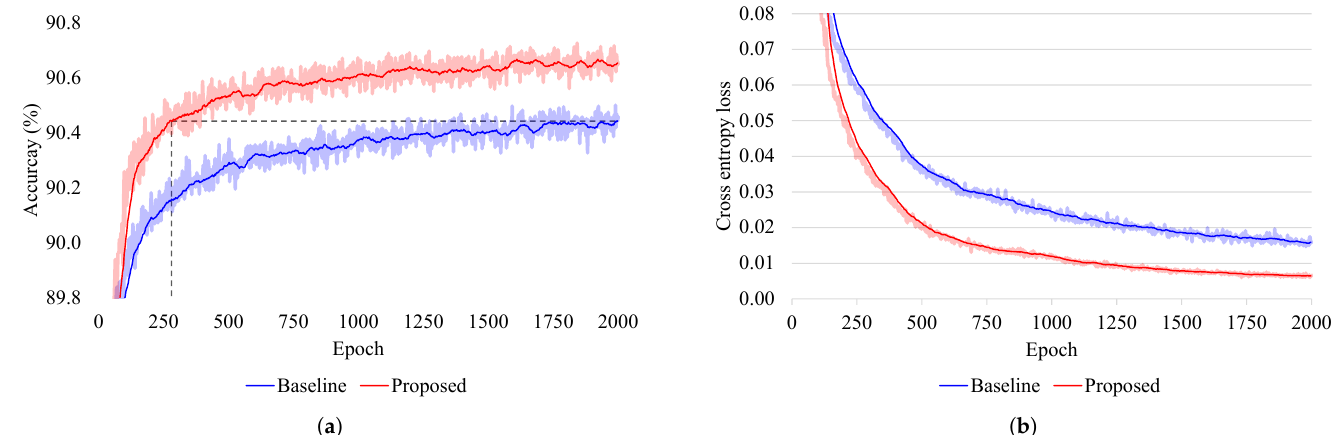
Figure 1. ( a ) Test set accuracy and ( b ) training loss over the course of training. We also plot the moving average of 20 epochs.